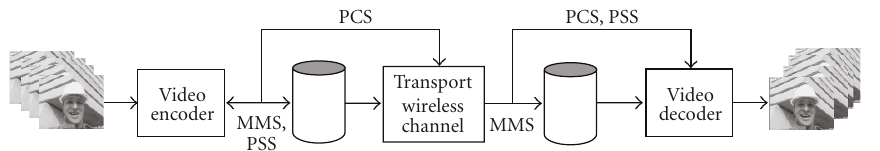
Figure 1: A simplified wireless video services system in FGWN.